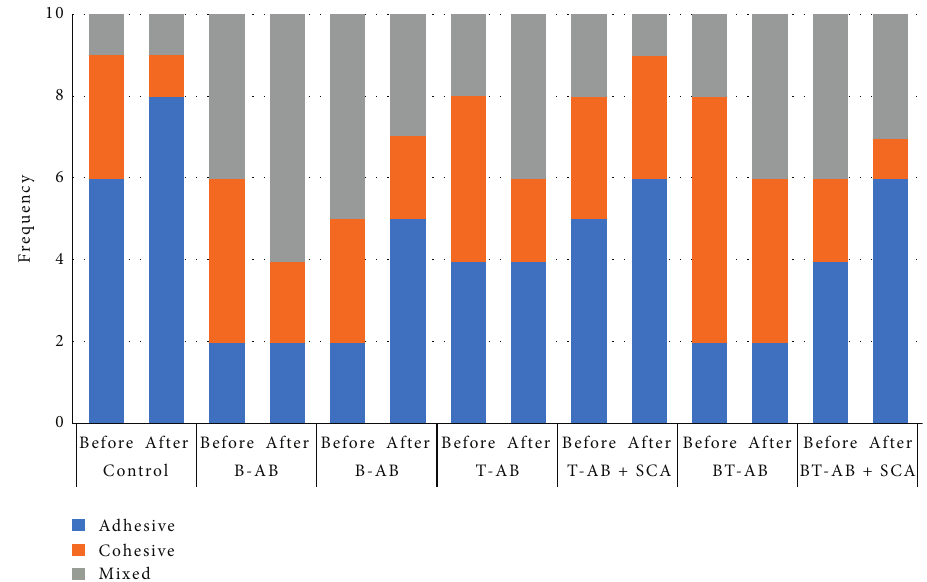
Figure 3: Summary of the nature of failure before and after thermal